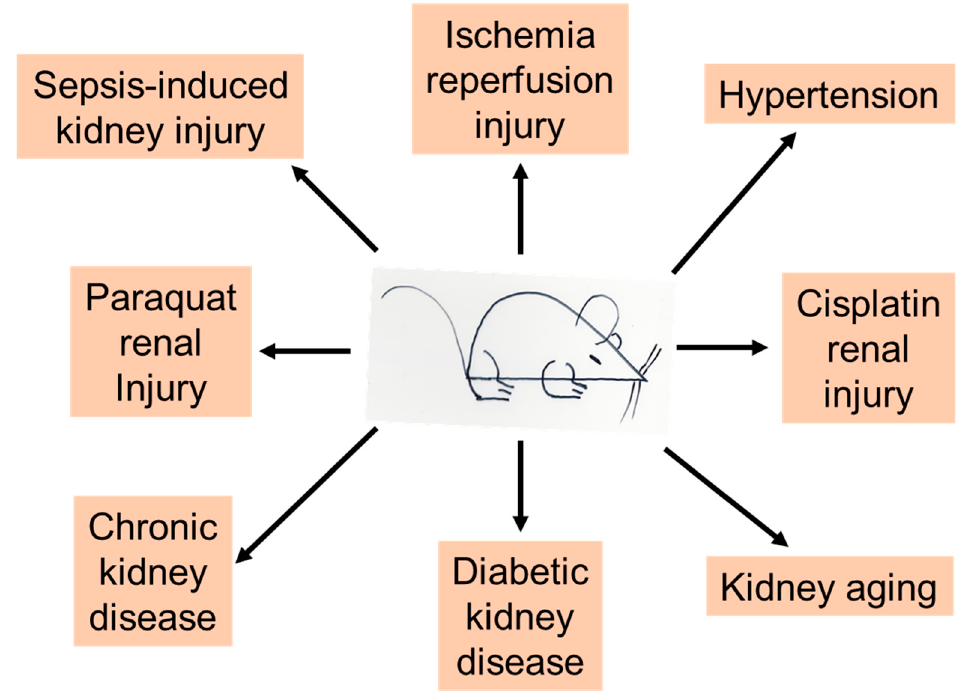
Figure 4. Animal models of kidney injury and kidney disease covered in this article. All these animal models show renal protective effects of ketone bodies regardless of whether they are endogenous or